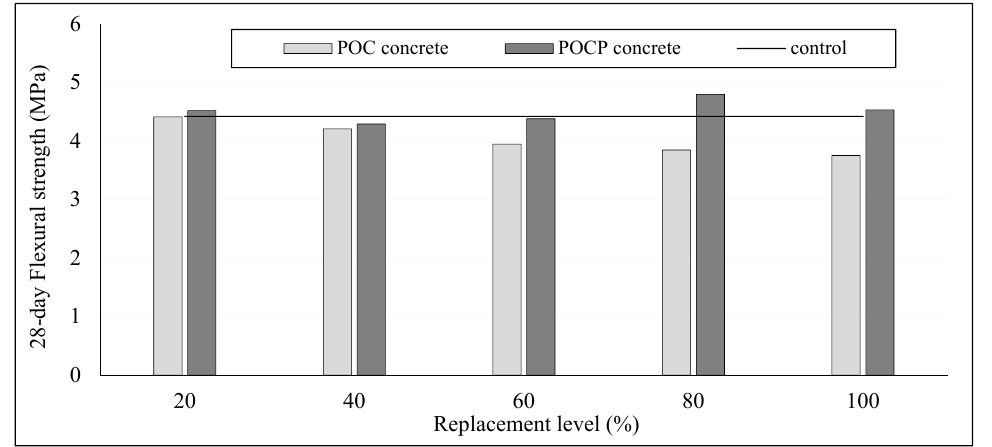
Figure 22. Developing of flexural strength of POCP concretes. 6.6. Modulus of Elasticity Modulus of elasticity (MOE) was conducted according to BS 1881: Part 121 on the cylinder specimens with a dimension of 150 mm diameter × 300 mm length. The results of the MOE of the concrete specimen containing different replacement levels of POC coarse with and without POCP are shown in Figure 23. Both POC and POCP concrete had a 28-day MOE ranging between 22 and 32 GPa, and the 28-day compressive strength ranged between 33 and 51 MPa. The incorporation of POC coarse negatively affected the MOE values of concrete. The results revealed that the MOE of the POC concrete was 9% to 31% lower than the control mix. Often, the quality of the coarse aggregate greatly affects the elastic modulus. A comparison between the MOE values of the POC and POCP concrete before and after coating at 28 days showed that the addition of POCP had a significant effect on the MOE of the POC concrete. POCP concrete had a 28-day MOE range between 28 and 32 GPa, which is 14%–46% higher than that of POC concrete (pre-coating). Furthermore, the addition of POCP resulted in the decreasing of the water to powder ratio, which benefited the elastic modulus property. Krizova et al. (2004) [33] studied the influence of the water-binder ratio on the static modulus of concrete and reported that using a lower volume of mixing water reduced the number of cracks created by drying, and consequently improved the elastic modulus.